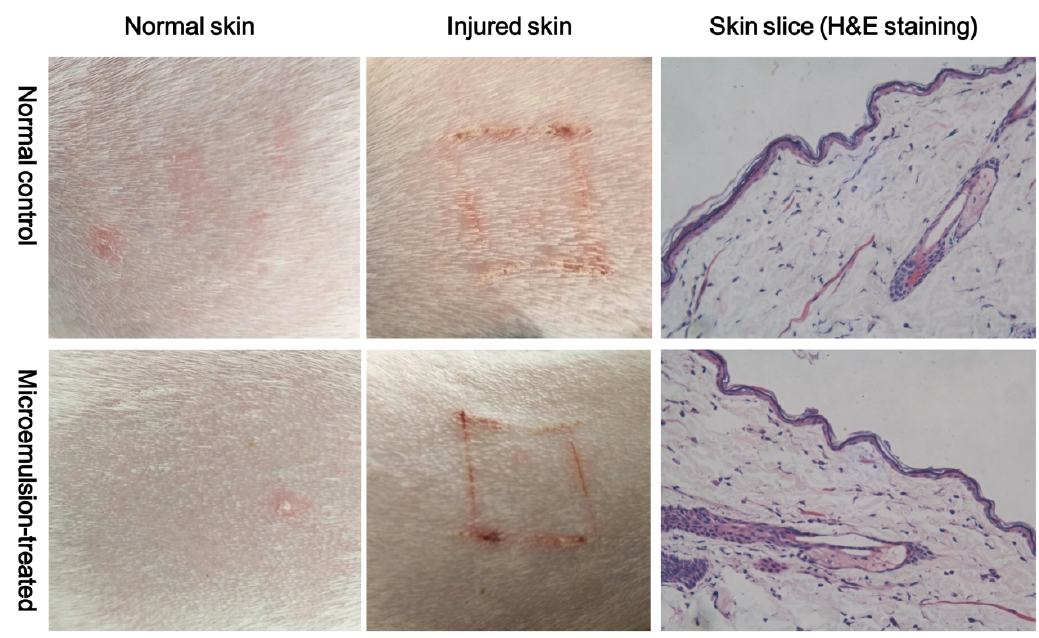
Figure 9. Normal and injured rat skin after being treated with aconitine-loaded microemulsion in vivo once a day for 7 days (H&E, hematoxylinandeosin). Magnification ×400.